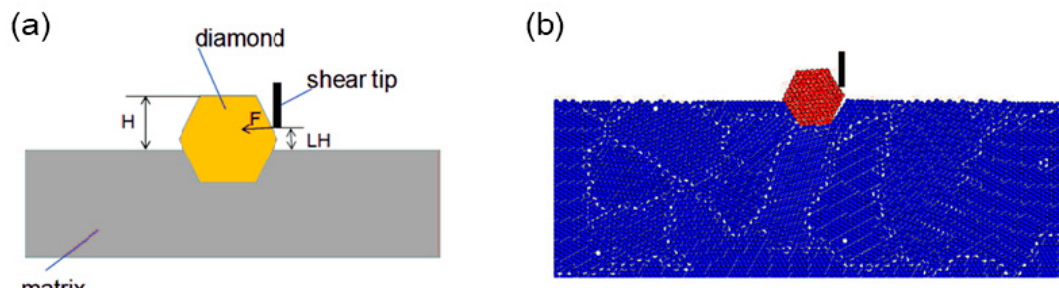
Figure 6. Single diamond shearing test: ( a ) schematic diagram; ( b ) simulation by DEM. Table 3. Critical force of diamond obtained by experiment and DEM simulations. Exposure Height (µm)